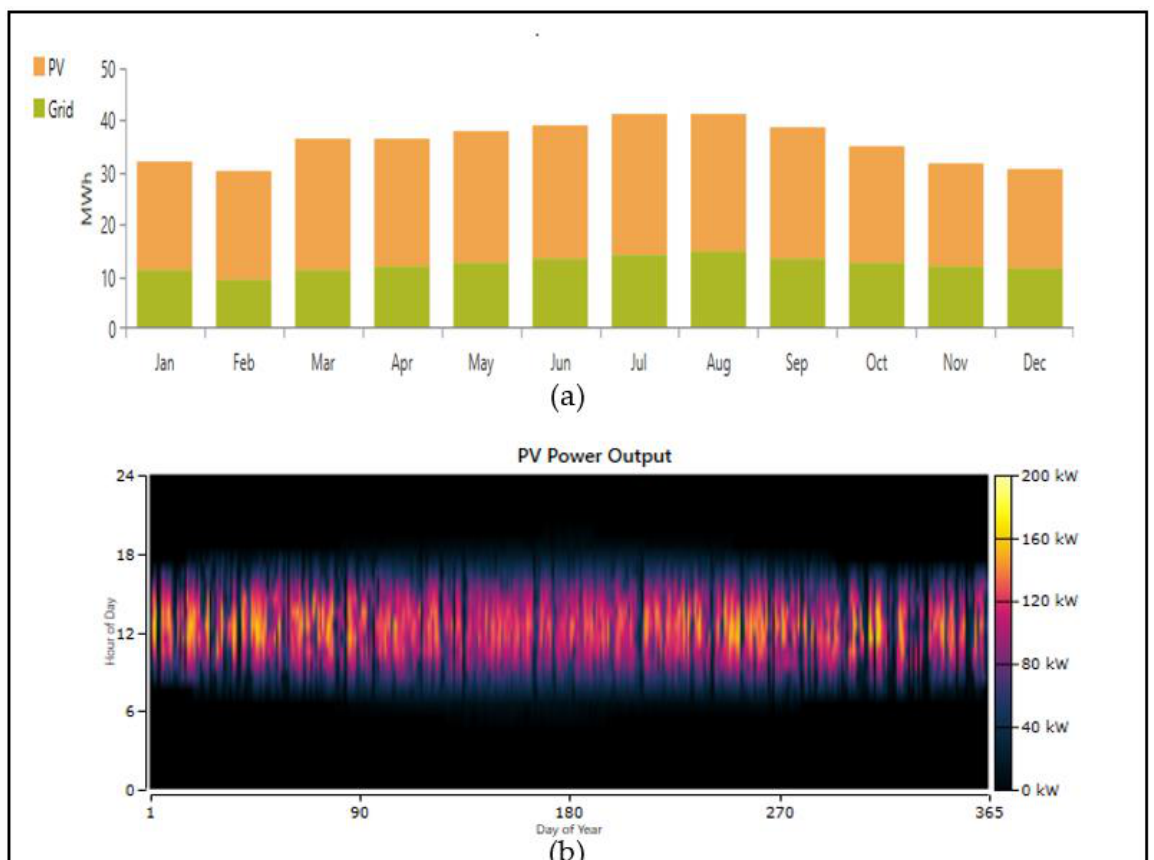
the model is taken as USD $49,500. The system lifetime is taken as 25 years with an average efficiency of 90%. Figure 11. Company 2 production profiles. ( a ) monthly PV production, ( b ) the PV hourly production. The generated electricity is utilized as follows: 63.9% (265,720 kWh/year) is con- sumed by the users, 36.1% (149,875 kWh/year) is sold back to the grid, and 5% was con-